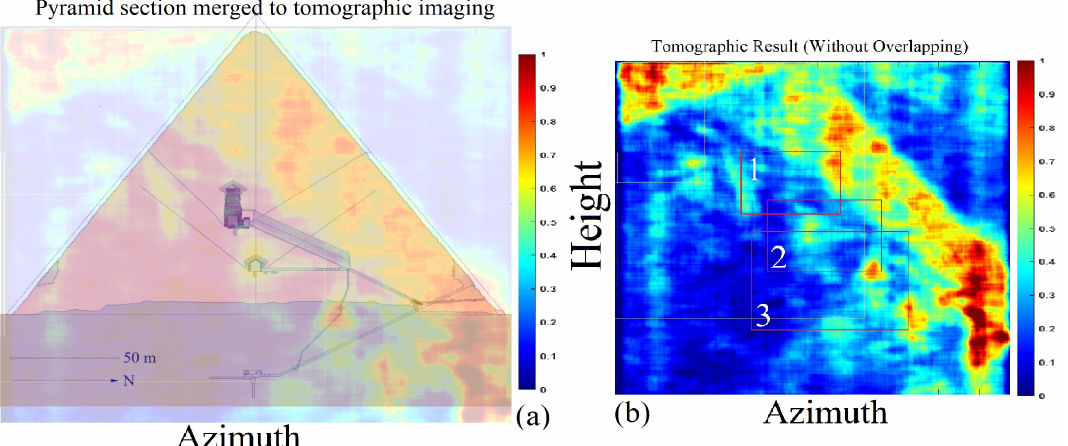
Figure 23. ( a ): SLC SAR of the pyramid of Khnum-Khufu. The V-shaped plot represents the tomographic line for which the vibrations were calculated, so that the inner section of the pyramid can be represented. ( b ): Internal scheme of the known structures.